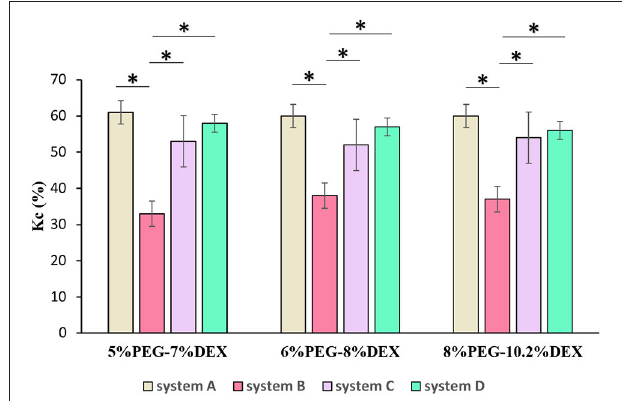
FIGURE 3 | Collagen partition coefficient (K c ) in four different systems using 5% PEG-7%DEX, 6% PEG-8% DEX, and 8% PEG-10.2% DEX concentration pairs. n = 4, * p < 0.05 (ANOVA with Bonferroni post-hoc